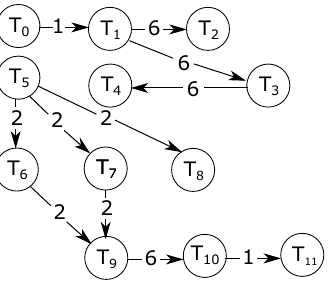
Figure 17. A sample app (inter-task required bandwidth in Mbps).